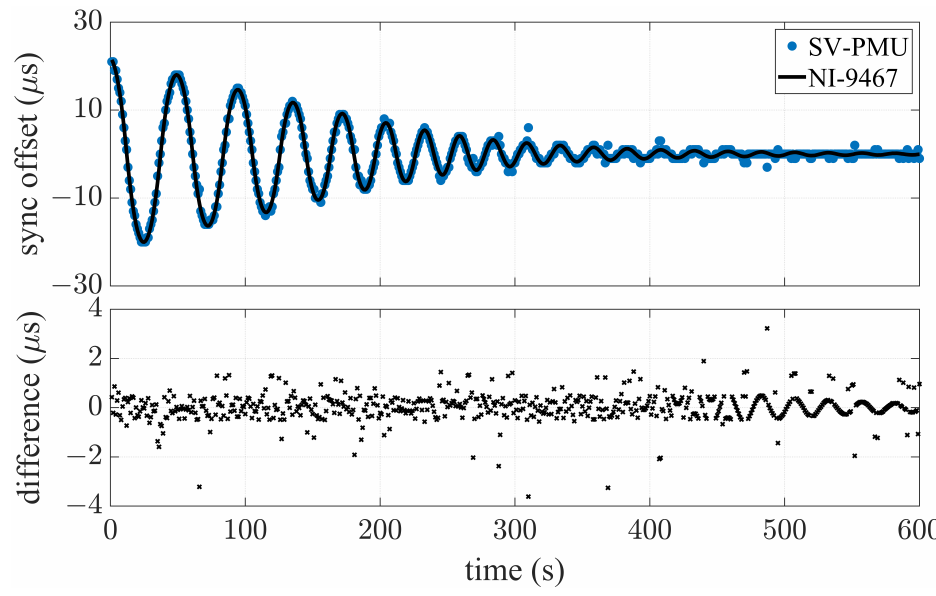
Figure 5. Top plot: offset from synchronization signal measured by the NI-9467 synchronization board (solid line) compared against t os p as measured by the SV-PMU (dots) vs. time. Bottom plot: difference between